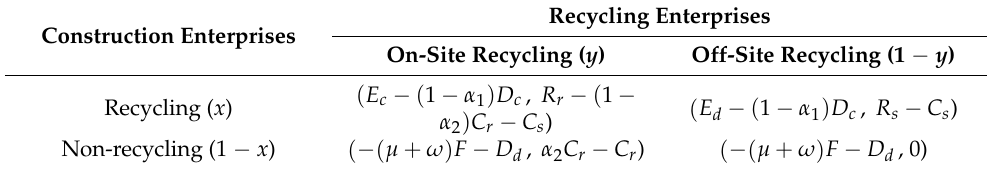
Table 5. The evolutionary game payoff matrix.